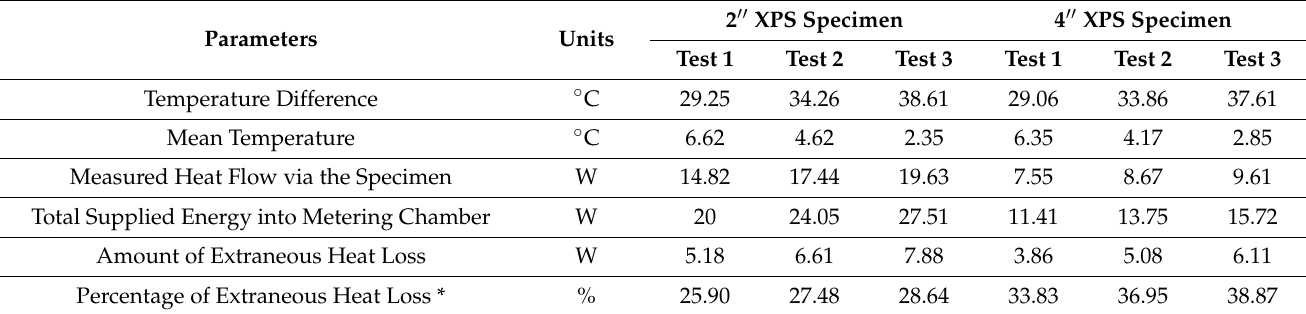
Table 4. Extraneous loss associated with hot box measurements.